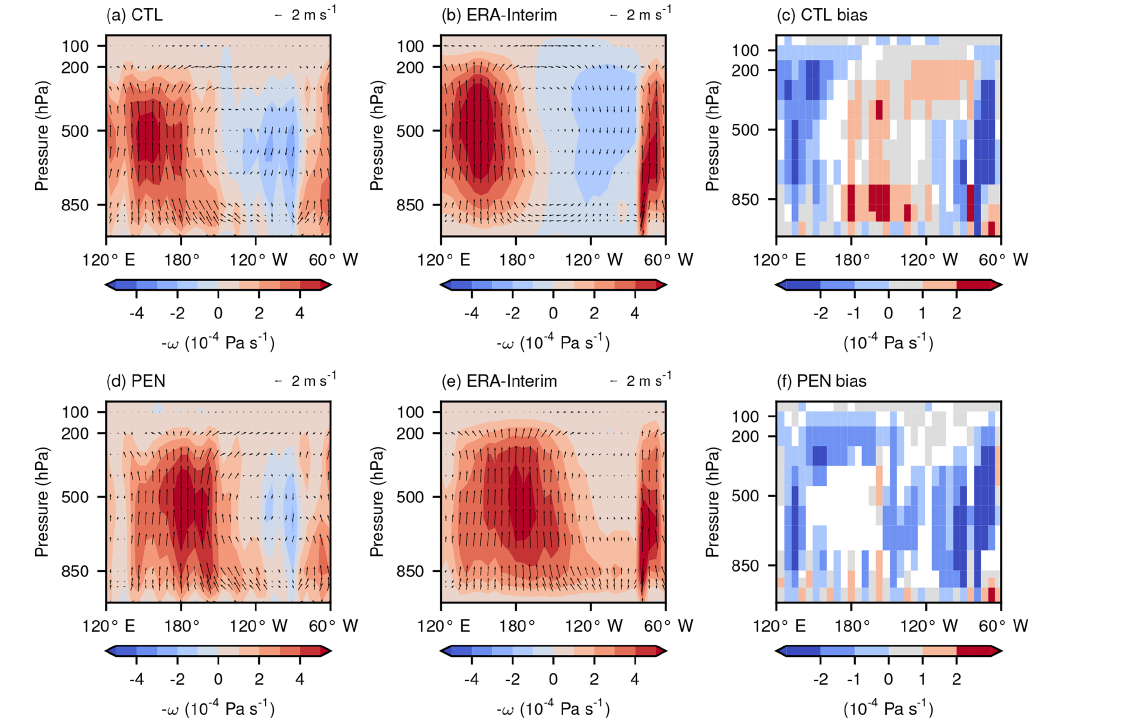
Figure 7. Meridional divergent circulation in the equatorial Pacific for the CTL simulation (a) , climatological ERA-Interim (b) , and CTL bias in vertical velocity values (c) , as well as for the PEN simulation (d) , ERA-Interim mean of 1997–1998 and 2015–2016 (e) , and PEN bias in vertical velocity values (f) . Vectors are plotted using the divergent meridional wind component and the negative vertical velocity in pressure units ( − ω ), averaged over latitudes 5 ◦ S to 5 ◦ N. Filled contours show the magnitude of the vertical velocity. In all bias panels, white is for statistically non-significant differences ( α = 0 .